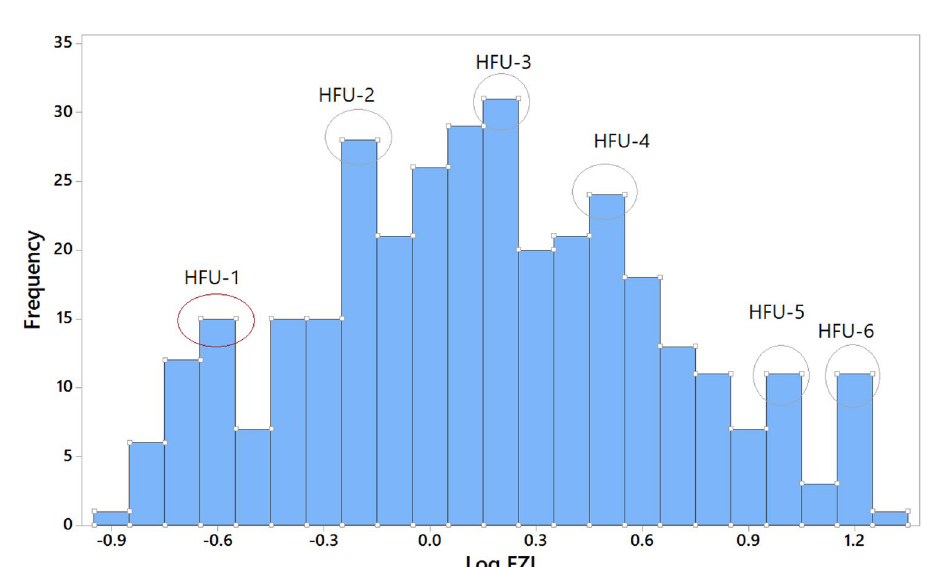
Log–Log plot of RQI versus Φ z According to Eq. 8, if RQI and normalized porosity values are plotted on a logarithmic scale, samples with the same FZI values will appear on a straight line with a single slope, and samples with different values of FZI will be aligned on parallel lines. In fact, samples on a line have the same tortuous properties and point to a single HFU. Fig- ure 14 shows six HFUs with a high correlation coefficient. Also, the mean FZI values are obtained from the intercept = 1) in the plot of RQI of each straight line equation ( Φ z vs. Φ (Fig. 14). These mean values are shown in Table 1. z 1 3